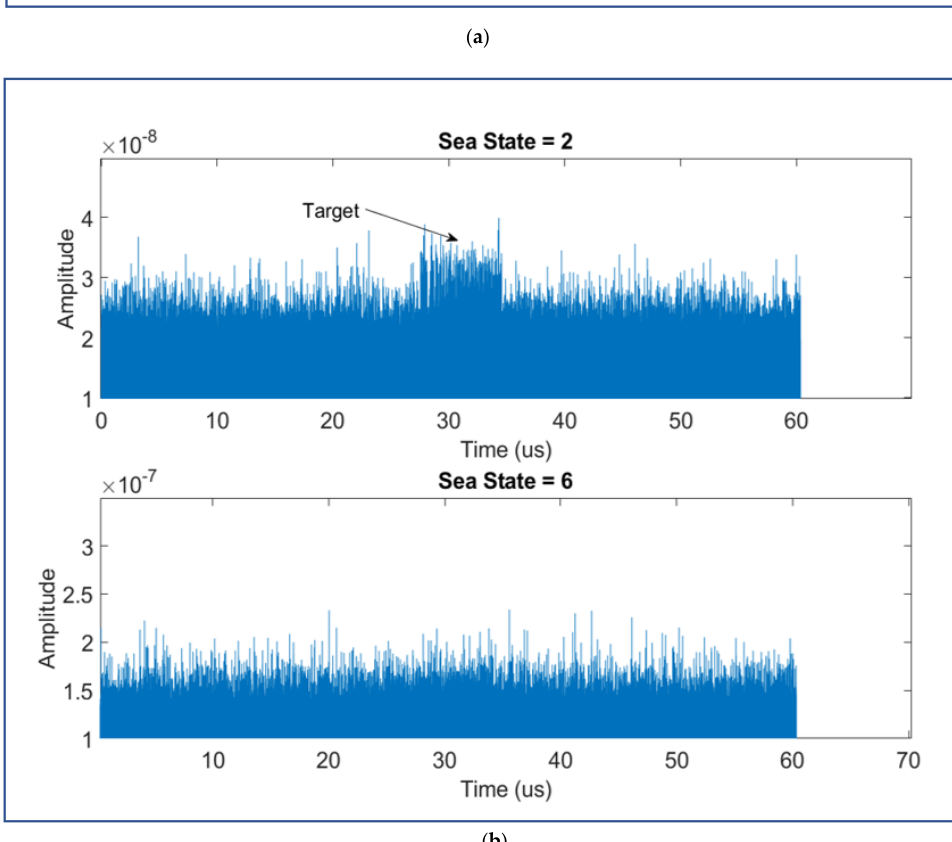
Figure 11. ( a ) impact of different object RCSs; ( b ) impact of different sea states.